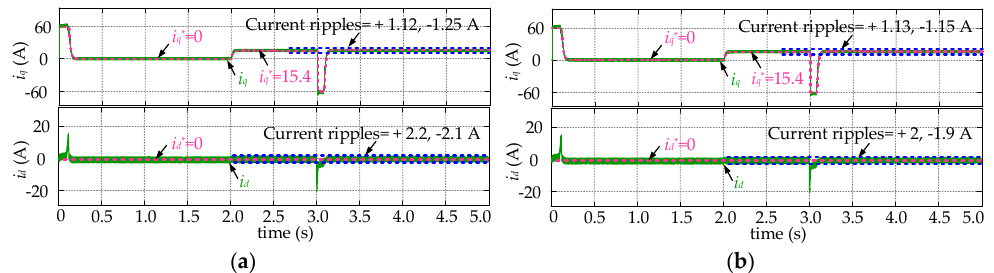
Figure 8. Current control performance of the proposed FCS-MPCC method under different resistance and inductance disturbances: ( a ) L 0 = 0.5 L , ∆ L = 0.5 L , R s0 = 0.5 R s , ∆ R s = 0.5 R s ; ( b ) L 0 = 2 L , ∆ L = − L , R s0 = 5 R s , ∆ R s = − 4 R s .